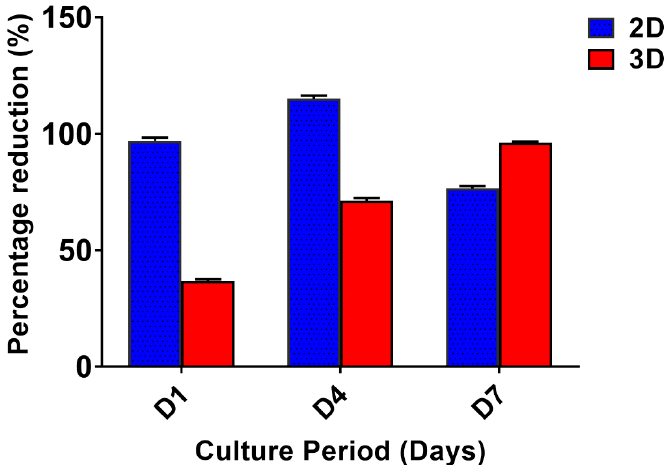
Figure 2. The cell proliferation of MDA-MB-231 cells grown on 2D and 3D silk fibroin constructs over a culture period of 7 days. The highest cell growth was observed on the 4th day in the 2D constructs. The proliferation of cells in 3D increased over time and was higher than 2D on the 7th day. The error bars indicate ± SD (standard deviation for n =